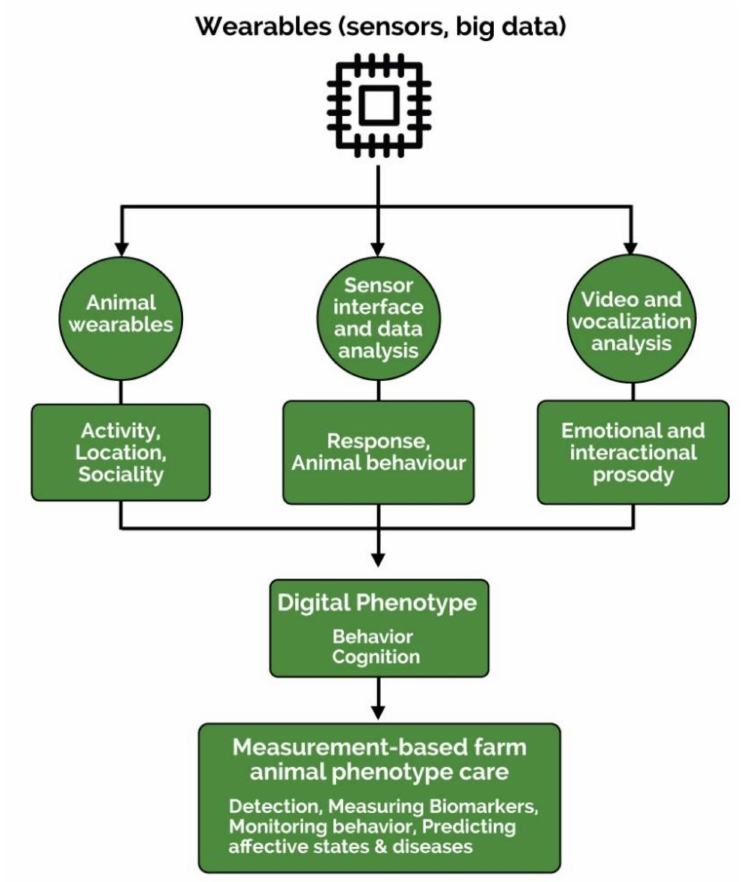
Figure 3. Digital phenotyping of farm animals involves collection of data from animal wearables and video and sound-based data to measure behavior and predict disease and